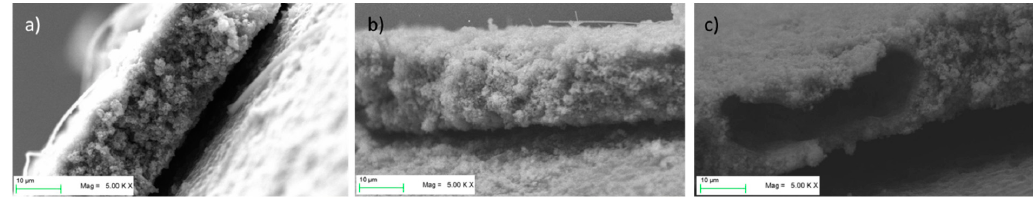
Figure 7. SEM cross-section images of electrodes after 80 cycles: ( a ) LTO-SA, ( b ) LTO-PVDF/CMC and ( c ) LTO-PVDF/SA.